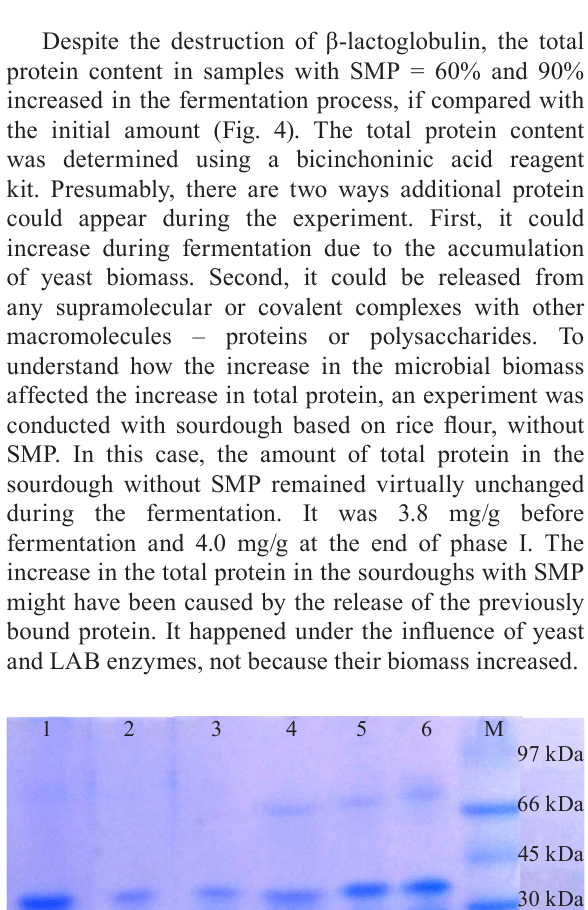
Figure 5 Content of β-lactoglobulin in the dough before and